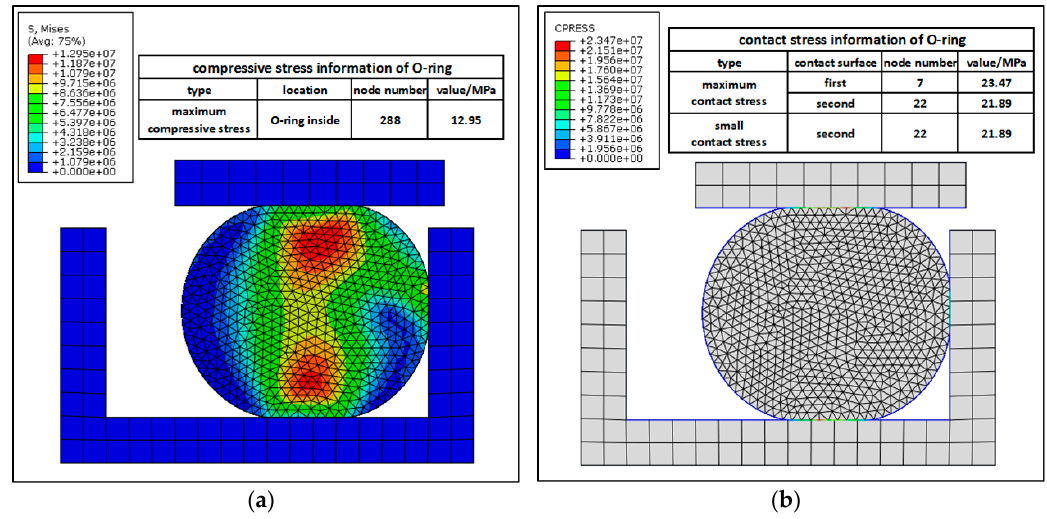
Figure 8. The stress nephogram of the O-ring: ( a ) distribution of compressive stress; ( b ) distribution of contact stress.